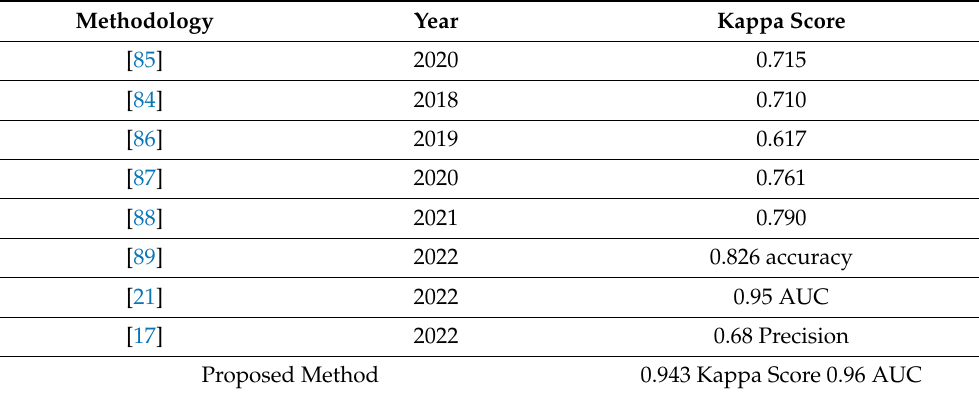
Table 5. Comparison of classification